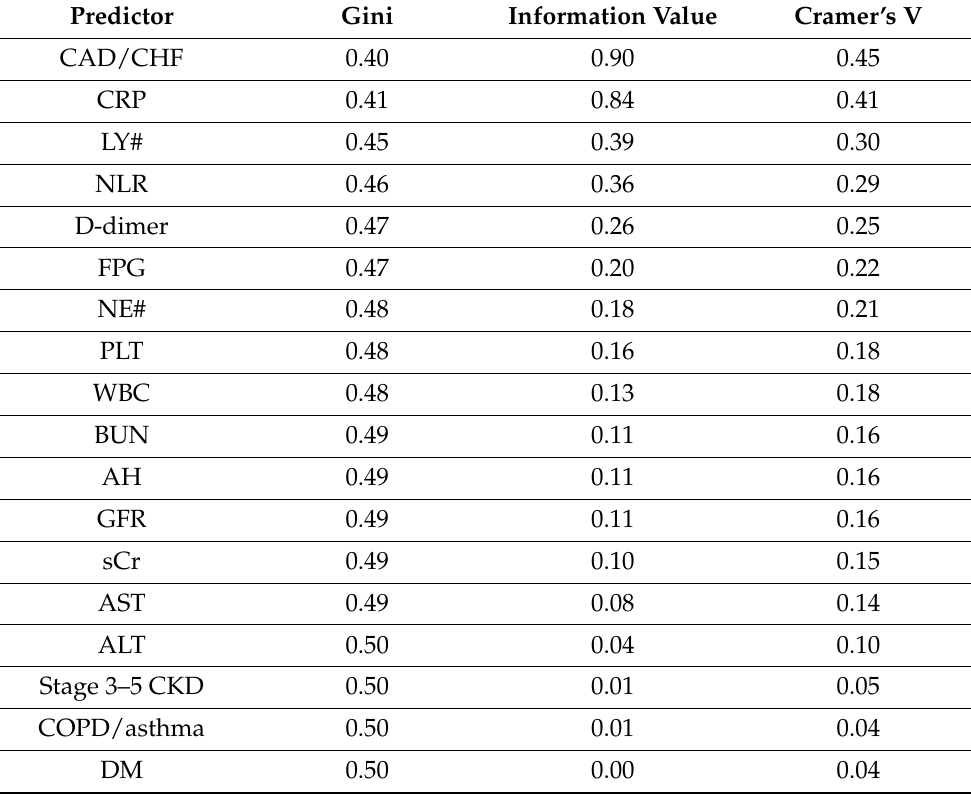
Table 5. Ranking of the predictors by the Predictor Screening tool of the STATISTICA software.